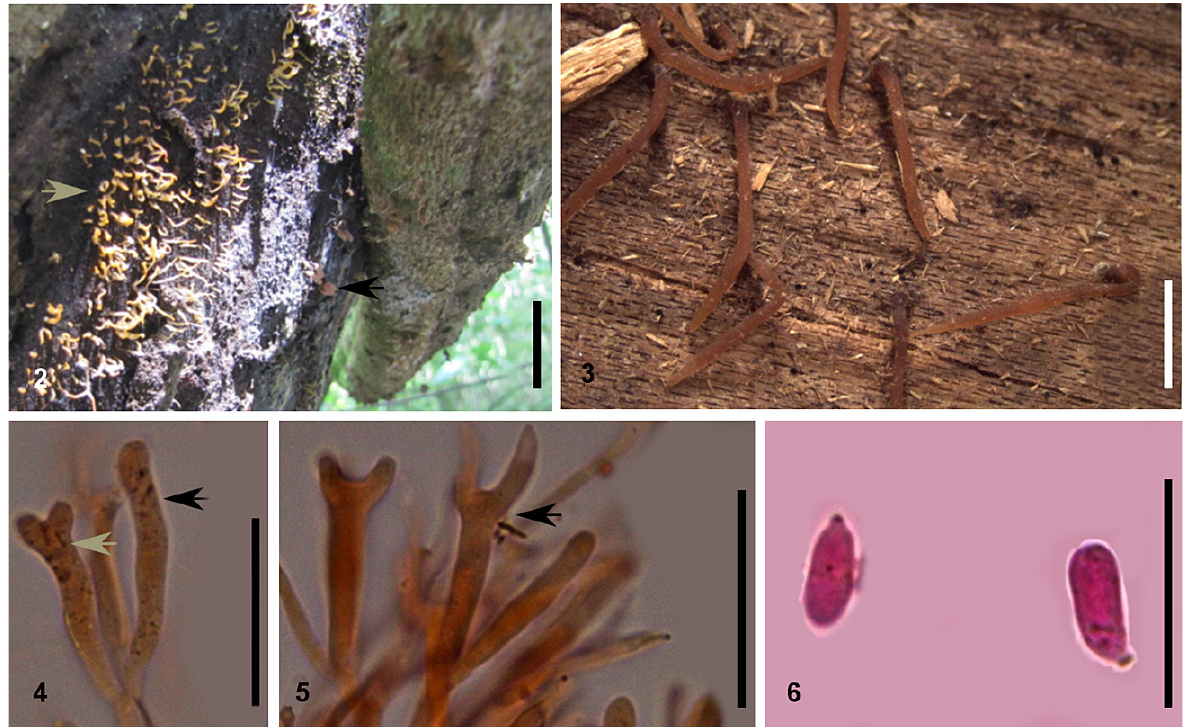
Figure 2–6. Calocera cornea . 2. Basidiomata of Calocera cornea when fresh (gray arrow) associated to sporacarp of myxomycetes Arcyria denu- data (black arrow): HUEG 10506, scale bar = 1 cm. 3. Basidioma when dried (HUEG 8438), scale bar = 2 mm. 4. Probasidia (black arrow)